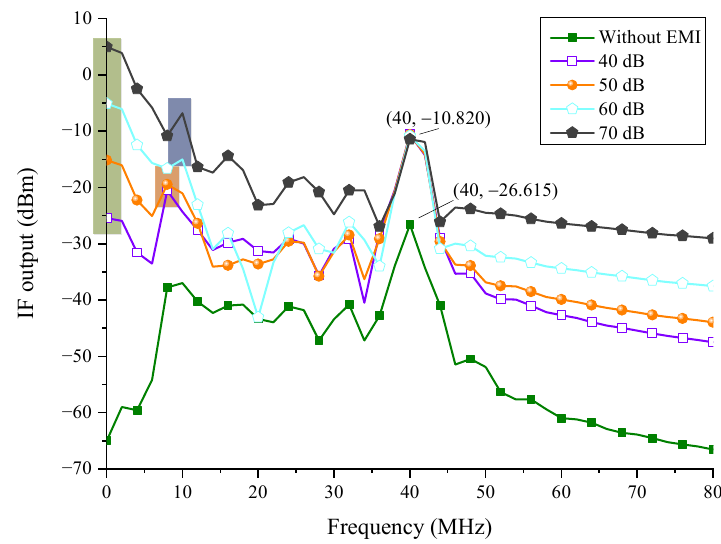
Figure 26. The injection interference law in nodes 5 and 6.